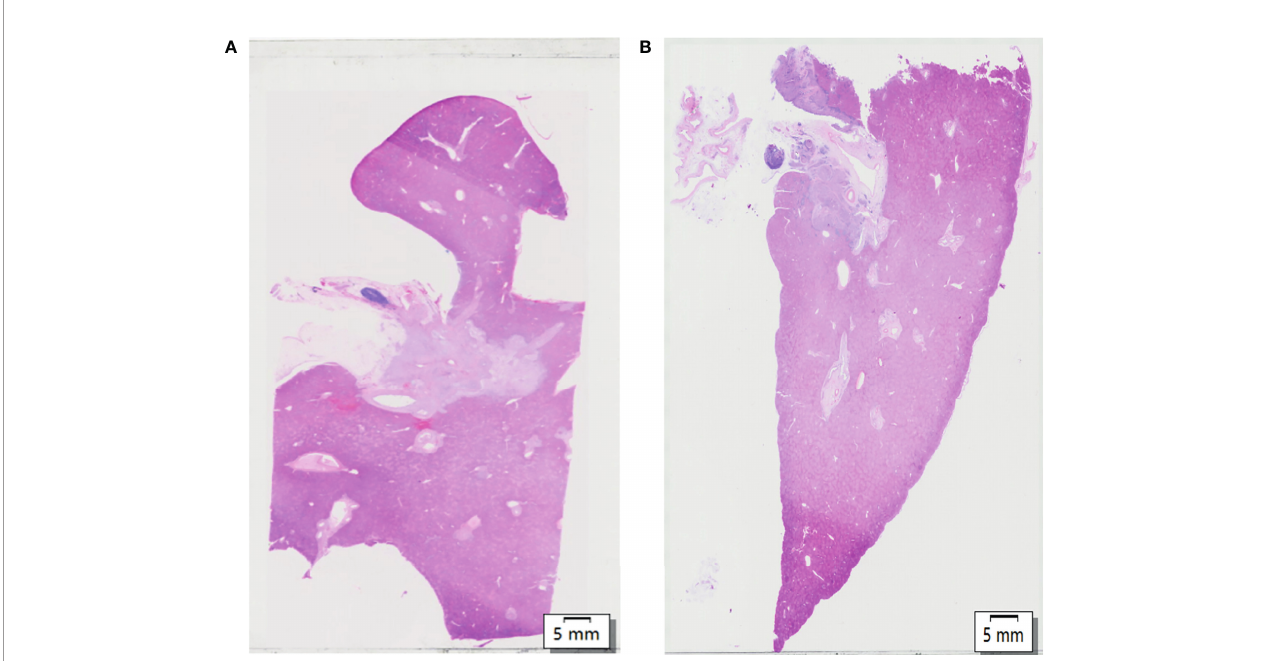
FIGURE 1 | (A, B) Hematoxylin and eosin (H&E) of whole-mount histologic large sections (WHLS) in Hilar cholangiocarcinoma (HCCA). Scale bar, 5